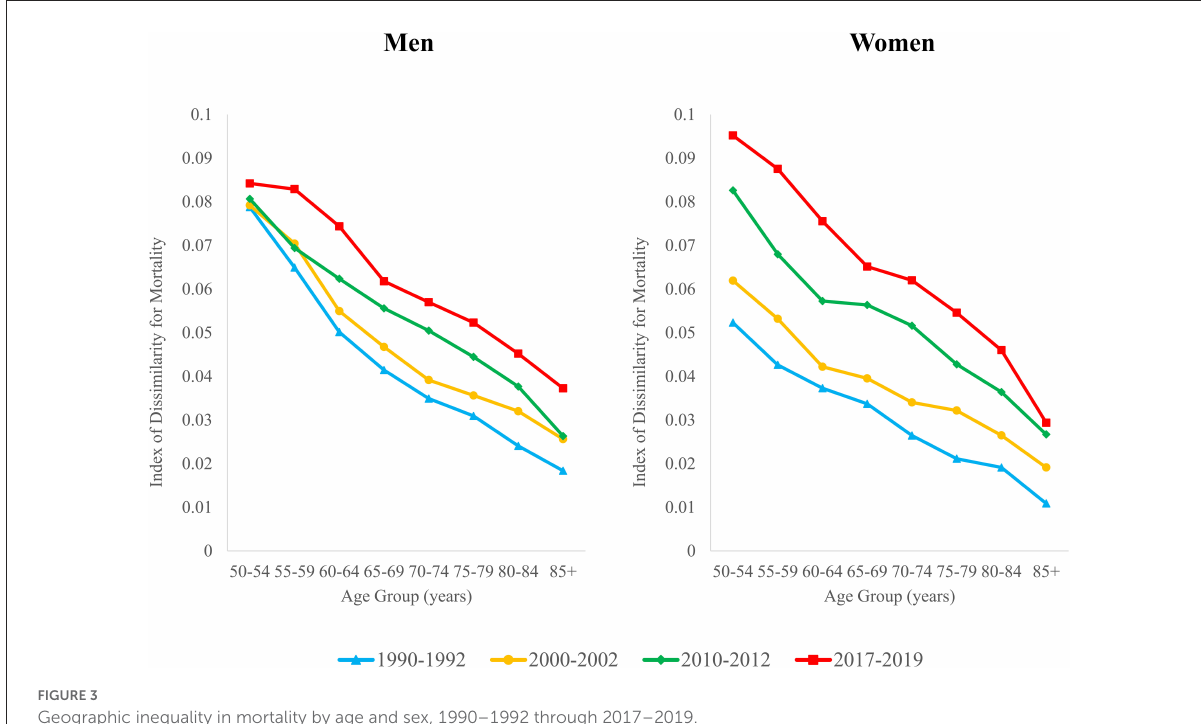
FIGURE3 Geographic inequality in mortality by age and sex, 1990–1992 through 2017–2019.